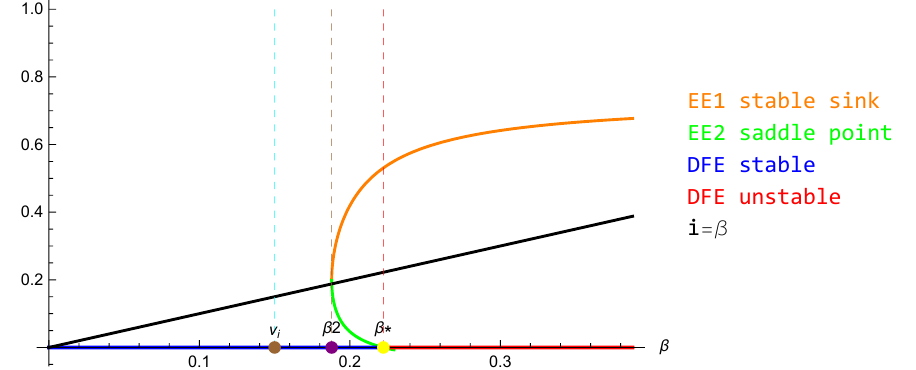
(+) ] < β r . For β < ν r i